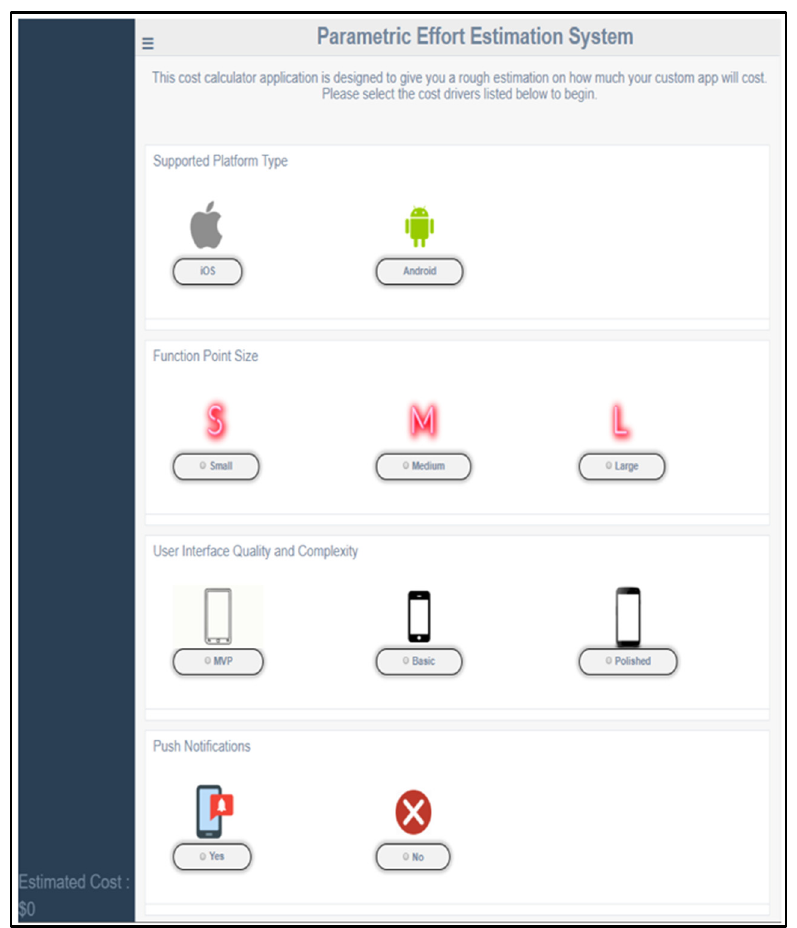
Figure 1. Main interface of proposed system.